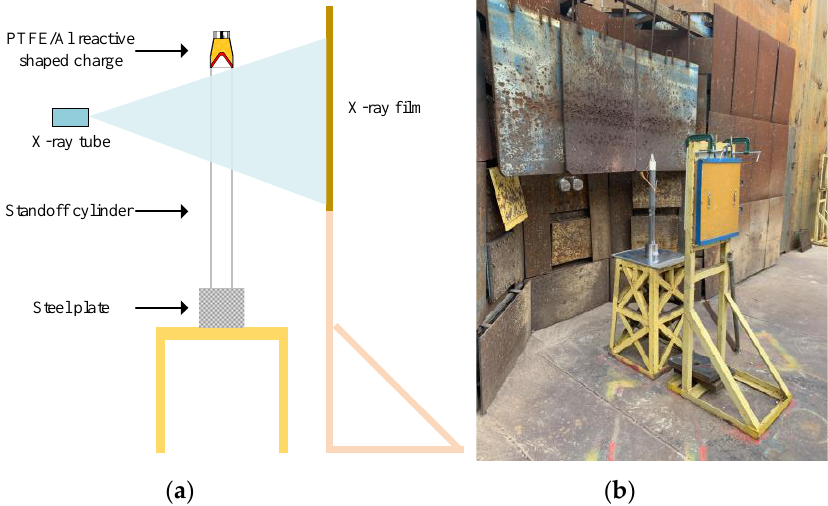
Figure 18. Pulse X-ray experiment ( a ) schematic and ( b )